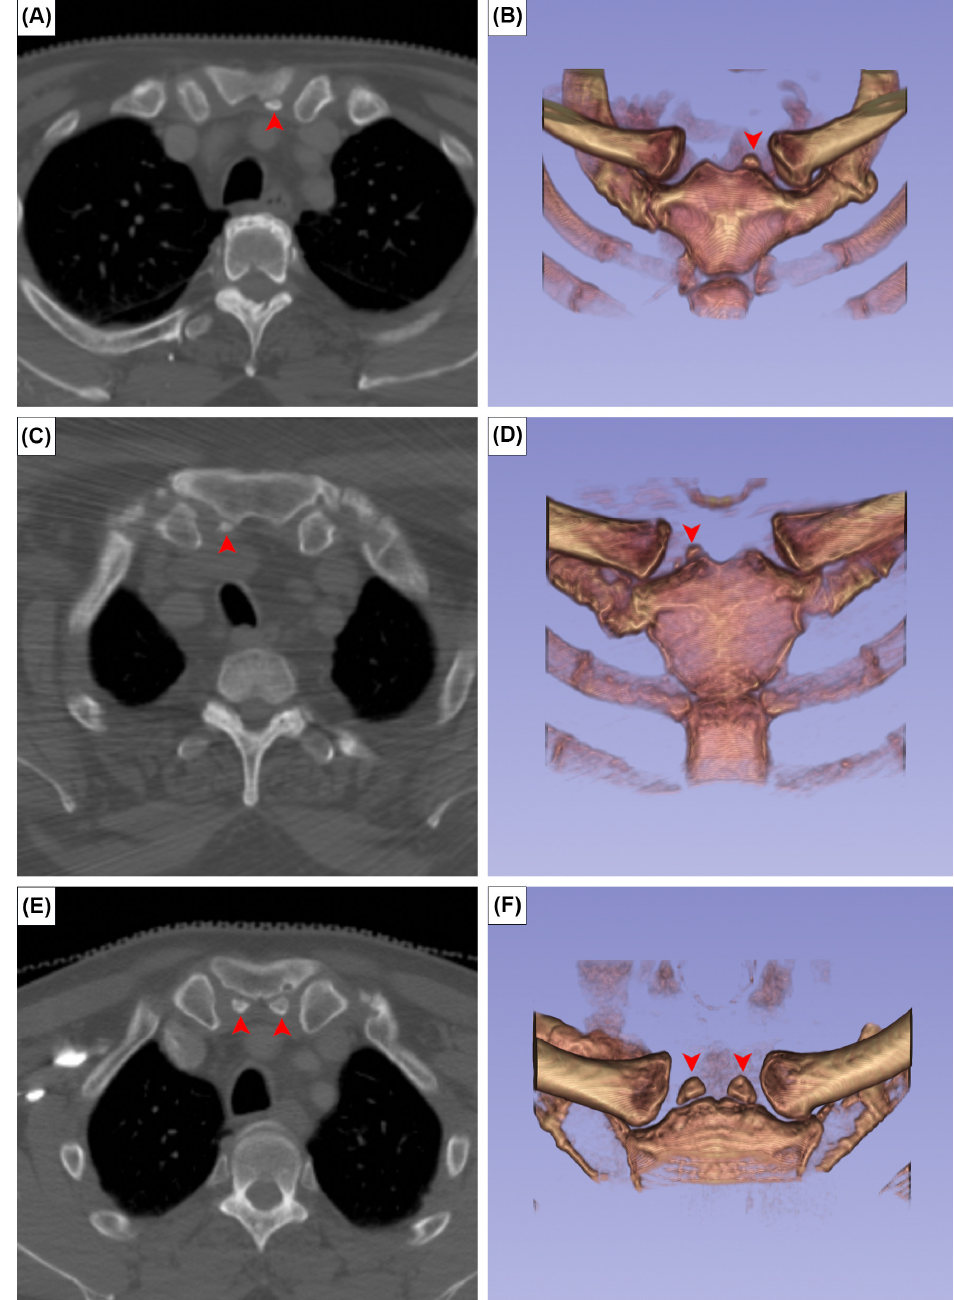
Figure 2. Axial CT images ( A , C , E ) and 3D reconstruction in anterior view of ( B , D , F ) the episternal ossicles, left-sided ( A , B ), right-sided ( C , D ), and bilateral ( E , F ) types. Red arrowheads indicate the episternal ossicles.